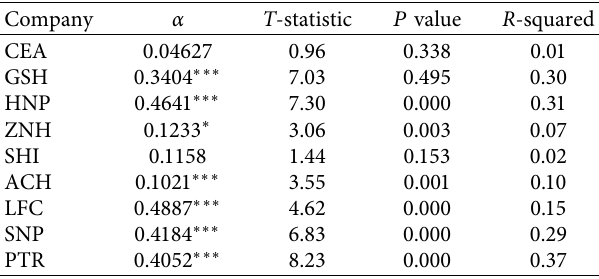
Table 4: Validation with dual-listed companies.